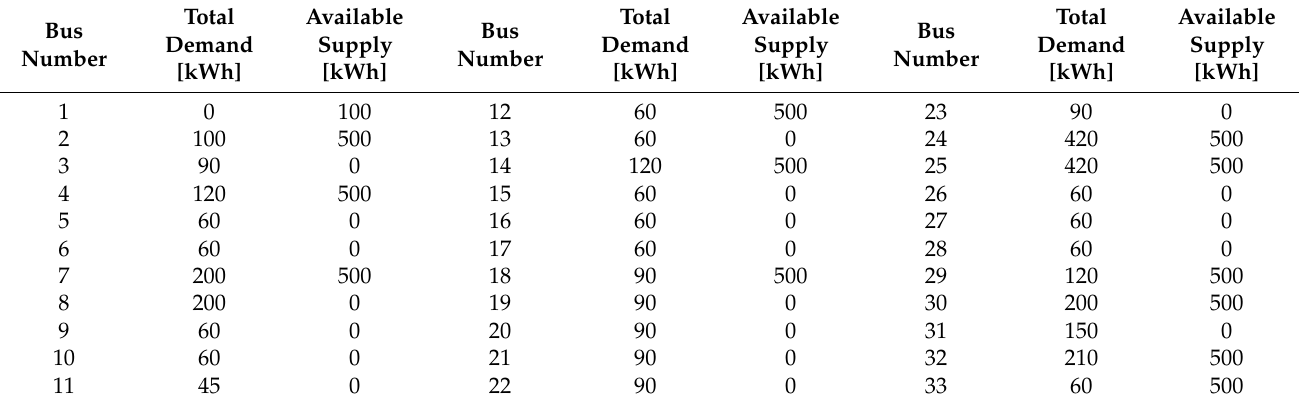
Table 2. Total demand and available supply at each bus in IEEE 33 radial network